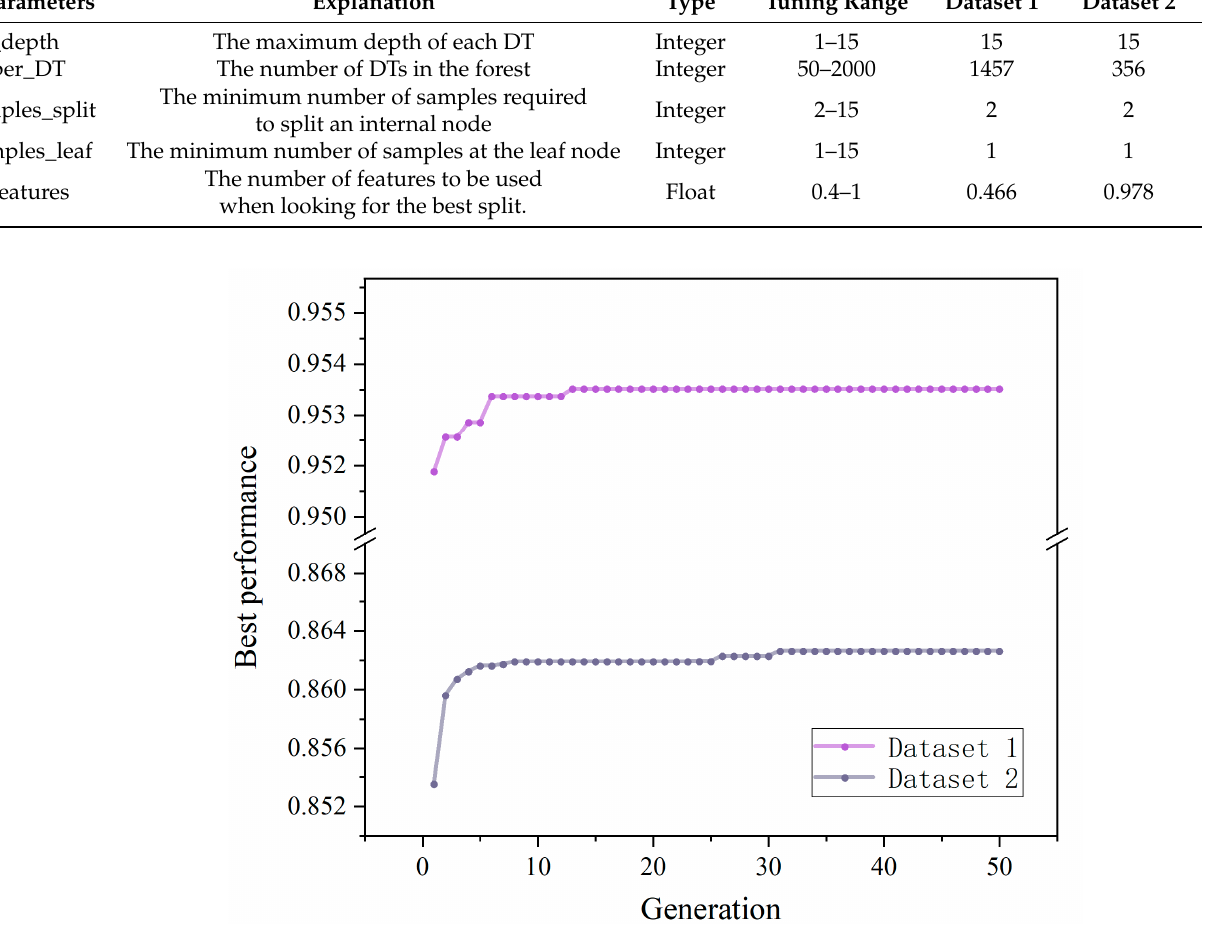
Figure 6. Evolution of G (cid:2912)(cid:2915)(cid:2929)(cid:2930) with PSO generations on two datasets. Table 2. Tuned RF hyper-parameters and their tuning outcome.